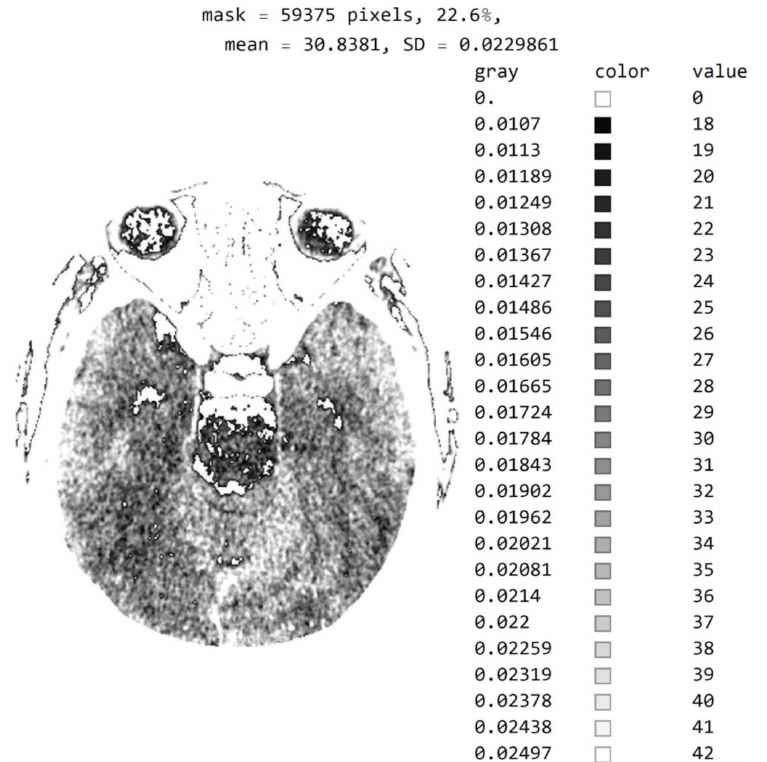
Figure 9. Image with exact integer values with shades of gray scaled from black (pixel value 18) to white (pixel value 42), with all other pixels outside this range shown as 0, i.e., white on the image.